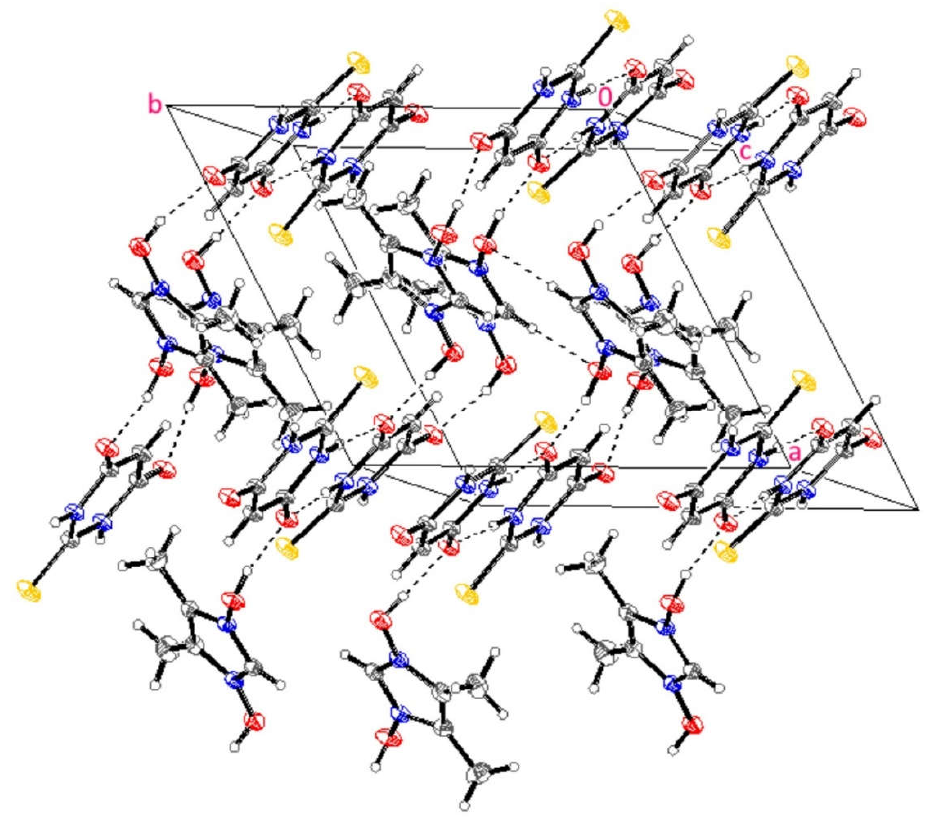
Figure 13. Supramolecular structure of TBA/HIMO cocrystal.